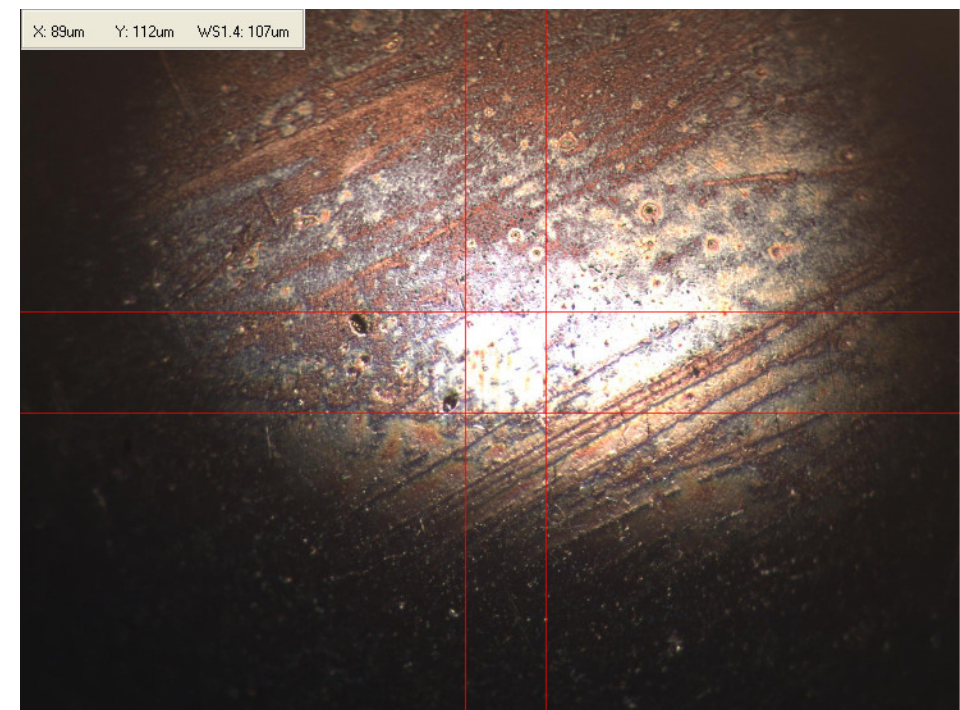
Figure A13. SAE 40—80% m/m; DO—20% m/m.